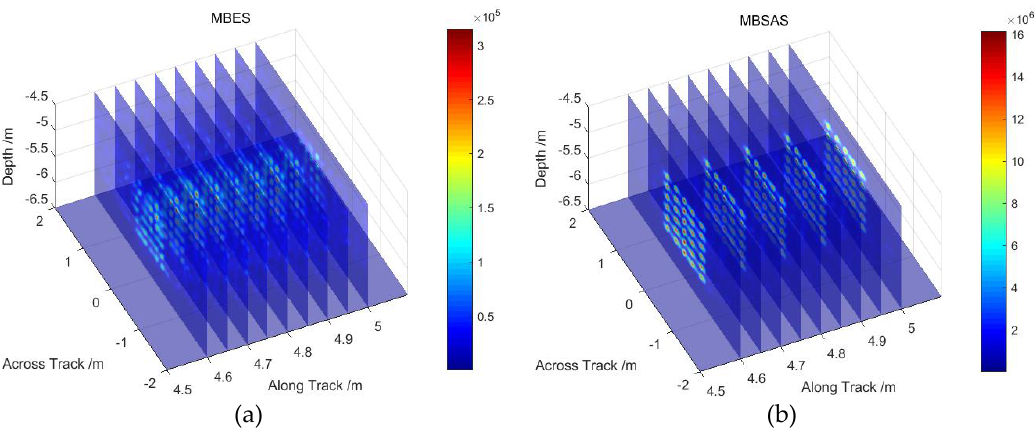
Figure 10. Comparison of 3D imaging algorithms: sliced view of ( a ) MBES image and ( b ) MBSAS image.